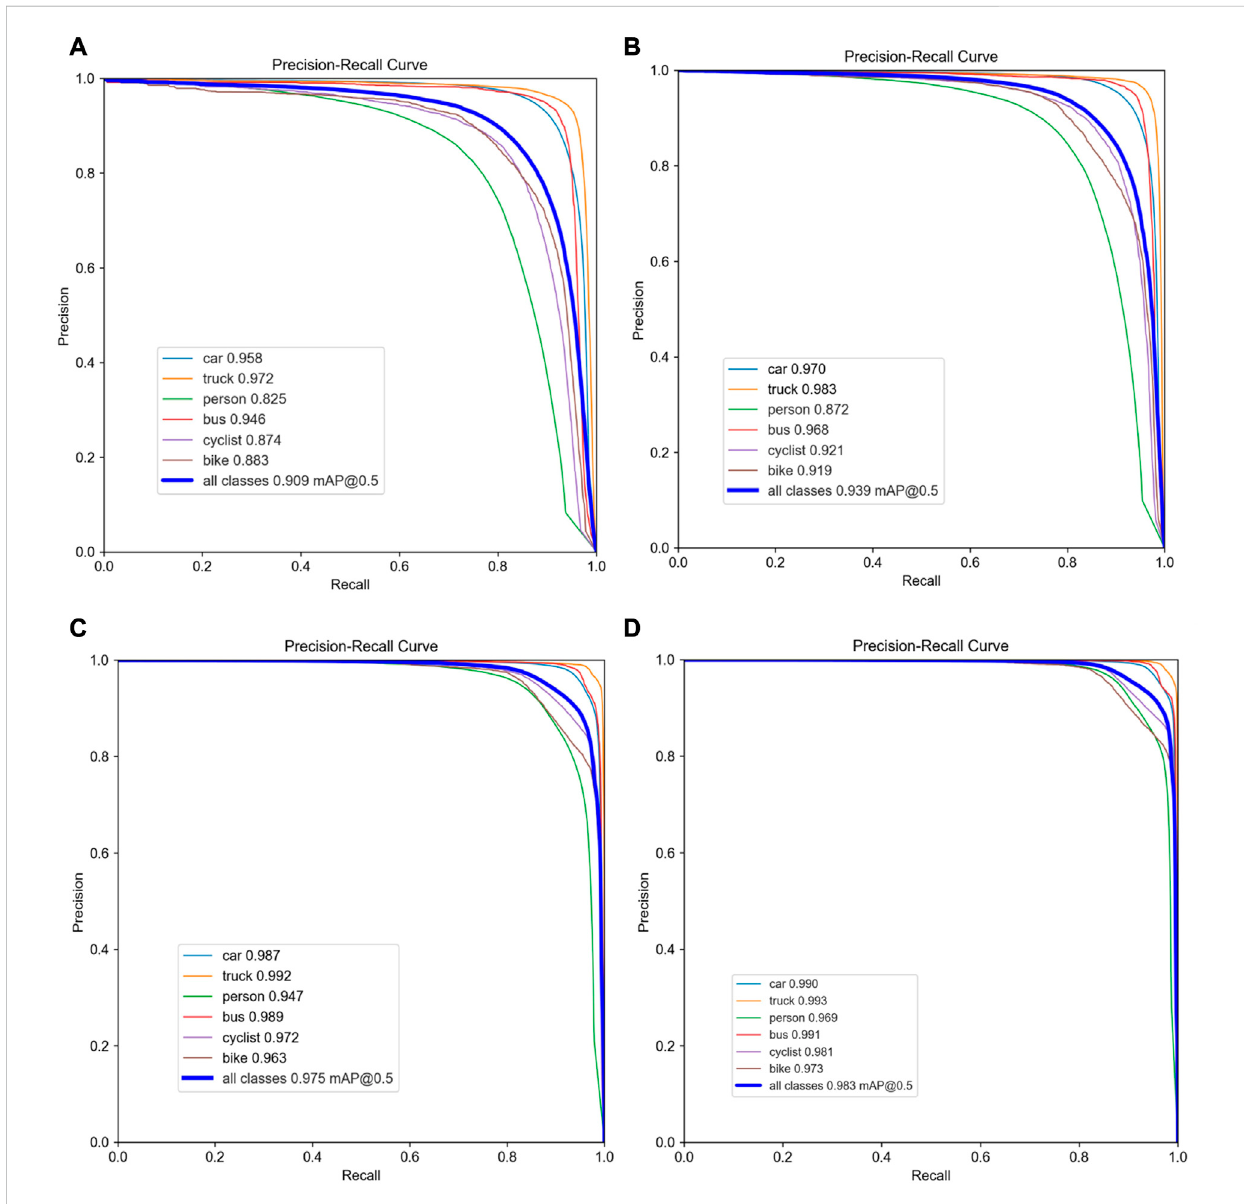
FIGURE 8 P-R curves of various model: (A) YOLOv5s (B) YOLOv5s + Ghost (C) YOLOv5s+Ghost +GCA (D) YOLOv5s+Ghost+GCA+CPA.